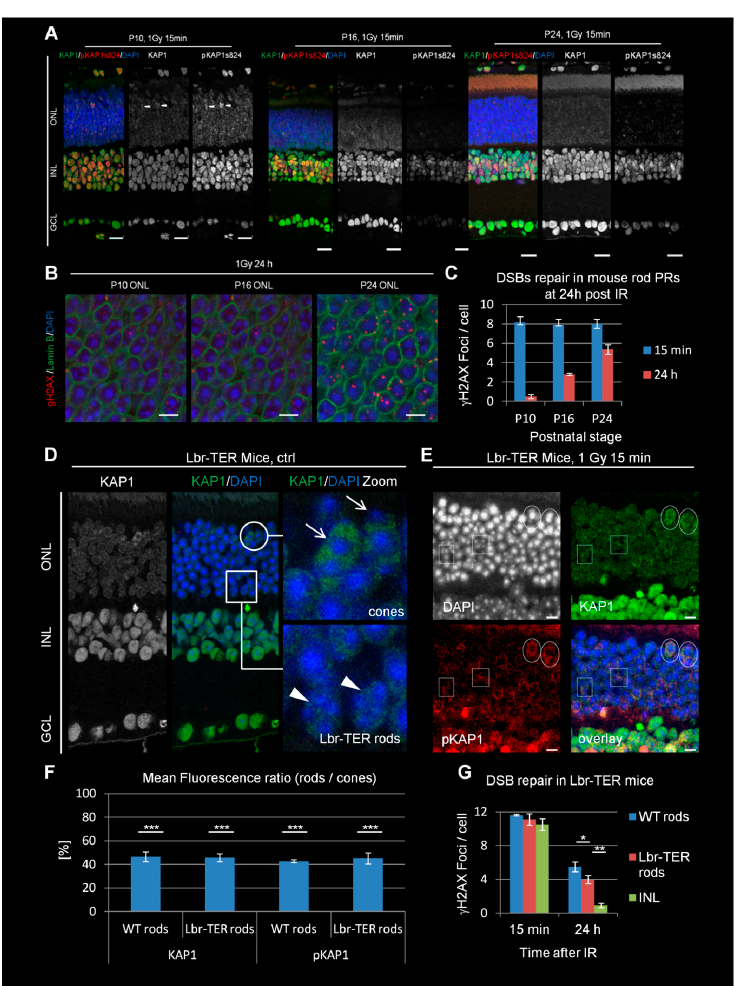
Figure 1. Double-stranded break (DSB) signaling and repair in developing WT and adult Lbr-TER mouse retinae. ( A ) Immunofluorescence images KAP1 (green) and radiation-induced pKAP1 (red) at 15 min after 1 Gy in the retinae of P10, P16, and P24 WT mice. Nuclei were counterstained with 4 ′ -6-Diamidin-phenylindol (DAPI) (blue). Scale bars represent 15 µ m. ( B ) Immunofluorescence images of γ H2AX (red) at 24 h after 1 Gy in the ONL of P10, P16, and P24 WT mice. Nuclei were counterstained with DAPI (blue) and nuclear borders with lamin B (green). Scale bars represent 5 µ m. ( C ) Quantification of residual IR-induced γ H2AX foci in rod photoreceptors (PRs) P10, P16, and P24 WT mice at 15 min and 24 h after 1 Gy. ( D ) Immunofluorescence images of KAP1 (green) in the retinae of adult Lbr-TER mice. Scale bar represents 15 µ m. Strong KAP1 expressing cones are encircled and marked by arrows in the enlarged pictures. Weakly KAP1 expressing Lbr-TER rods are framed by boxes and marked by arrowheads in the enlarged pictures. ( E ) Immunofluorescence images of KAP1 (green) and radiation-induced pKAP1 (red) in the retinae of adult Lbr-TER mice at 15 min after 1 Gy. Scale bar represents 5 µ m. Strong KAP1 expressing cones with IR-induced pKAP1 signals are encircled. Boxes show Lbr-TER rods with weak KAP1 expression and no IR-induced pKAP1 signals. (F) Quantification of the KAP1 and pKAP1 signals in the nuclei of WT and Lbr-TER rods in comparison to cones. The pKAP1 ratio was measured at 15 min after 1 Gy. ( G ) Quantification of residual IR-induced γ H2AX foci in WT and Lbr-TER rod PRs at 15 min and 24 h after 1 Gy. All quantitative data are presented as mean ± SEM from three experiments ( n = 3). p -values were obtained by t -test and represent a comparison of all cells analyzed in the indicated cell population (at least 40 cells per data point and experiment for foci quantification and 10 nuclei for KAP1 / pKAP1 fluorescence measurements in rods and cones) with *: p < 0.05; **: p < 0.01, and ***: p < 0.001. ONL = outer nuclear layer, INL = inner nuclear layer, GCL = ganglion cell